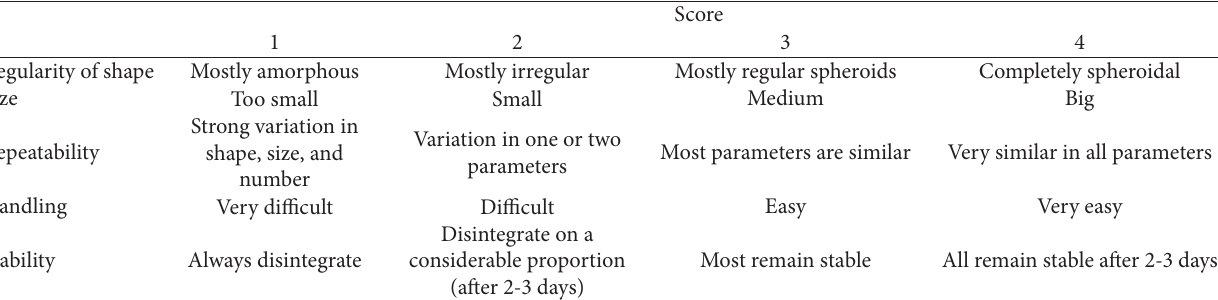
Table 1: Parameters and scores for the qualitative assessment of the